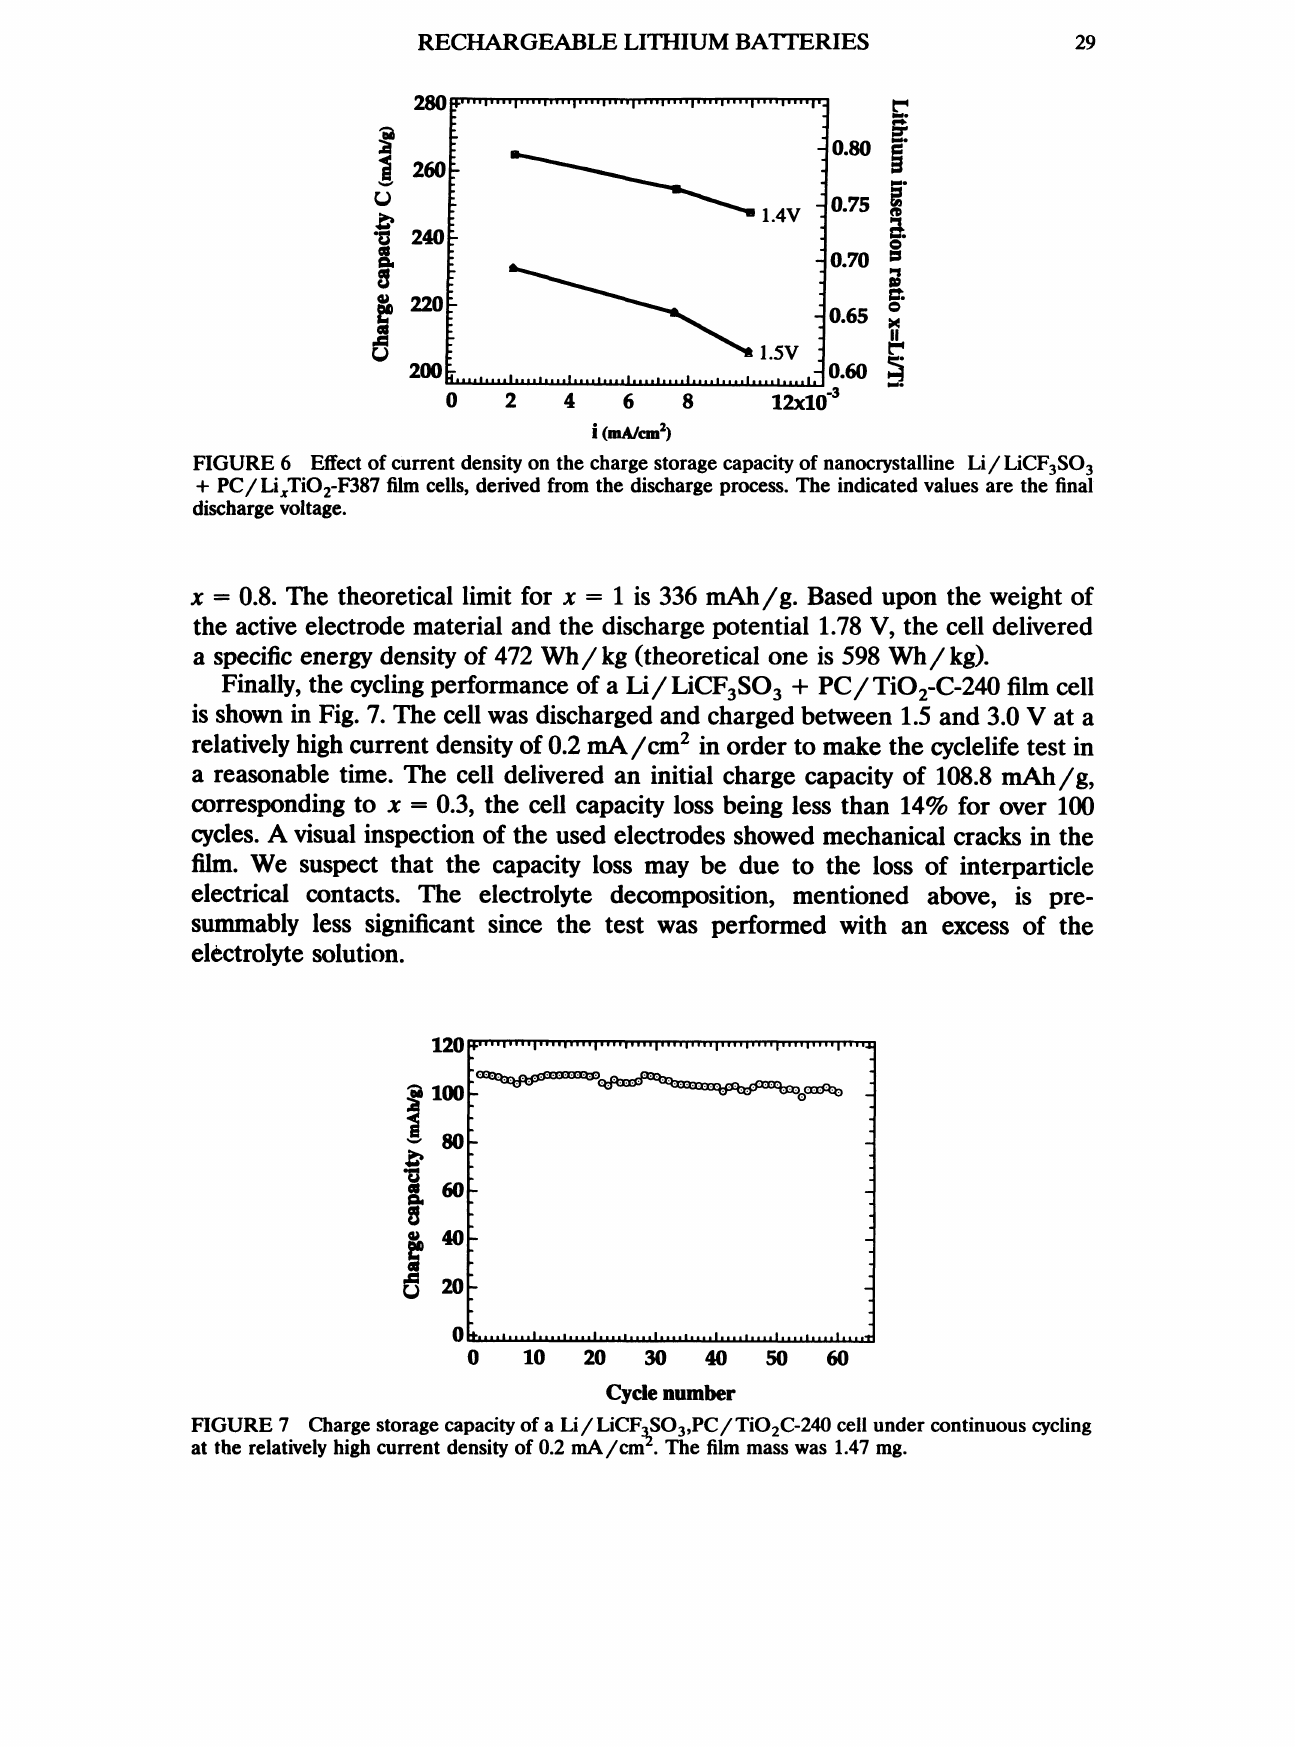
FIGURE 7 Charge storage capacity of a Li/LiCF3SO3,PC/TIO2C-240 cell under continuous cycling at the relatively high current density of 0.2 mA/cmL The film mass was 1.47